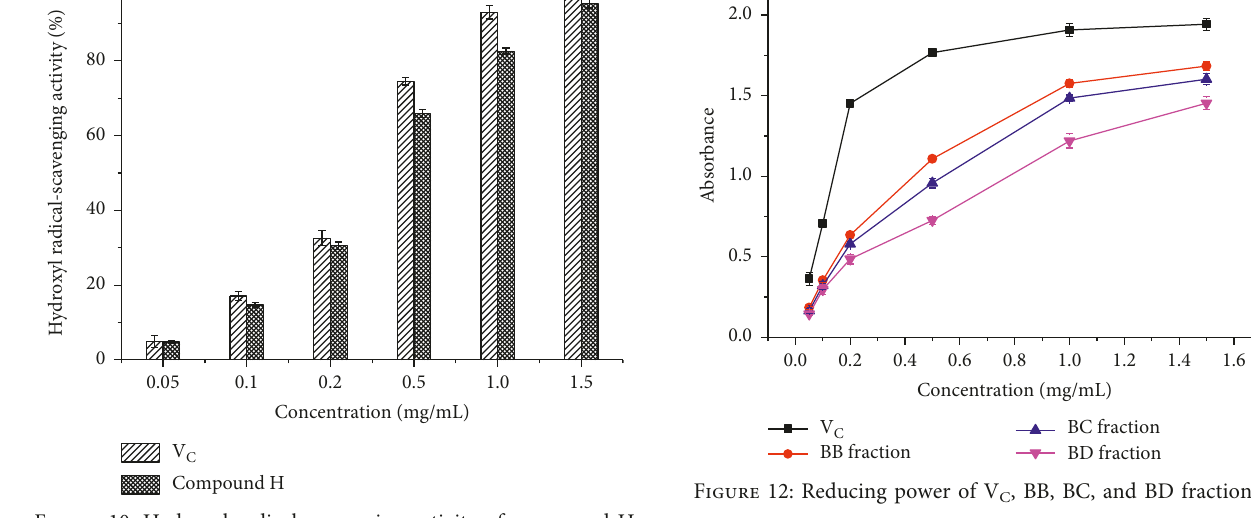
Figure 10: Hydroxyl radical-scavenging activity of compound H and V C .